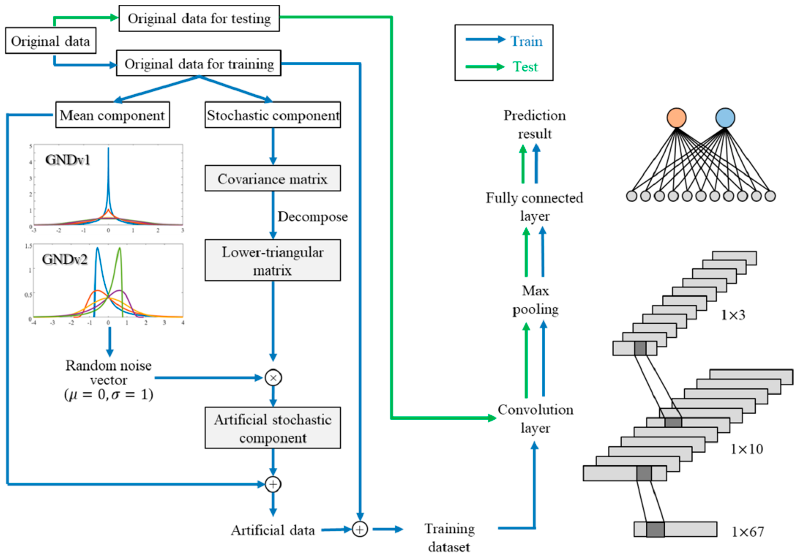
Figure 4. Training and test pipeline using data augmentation via CMD.